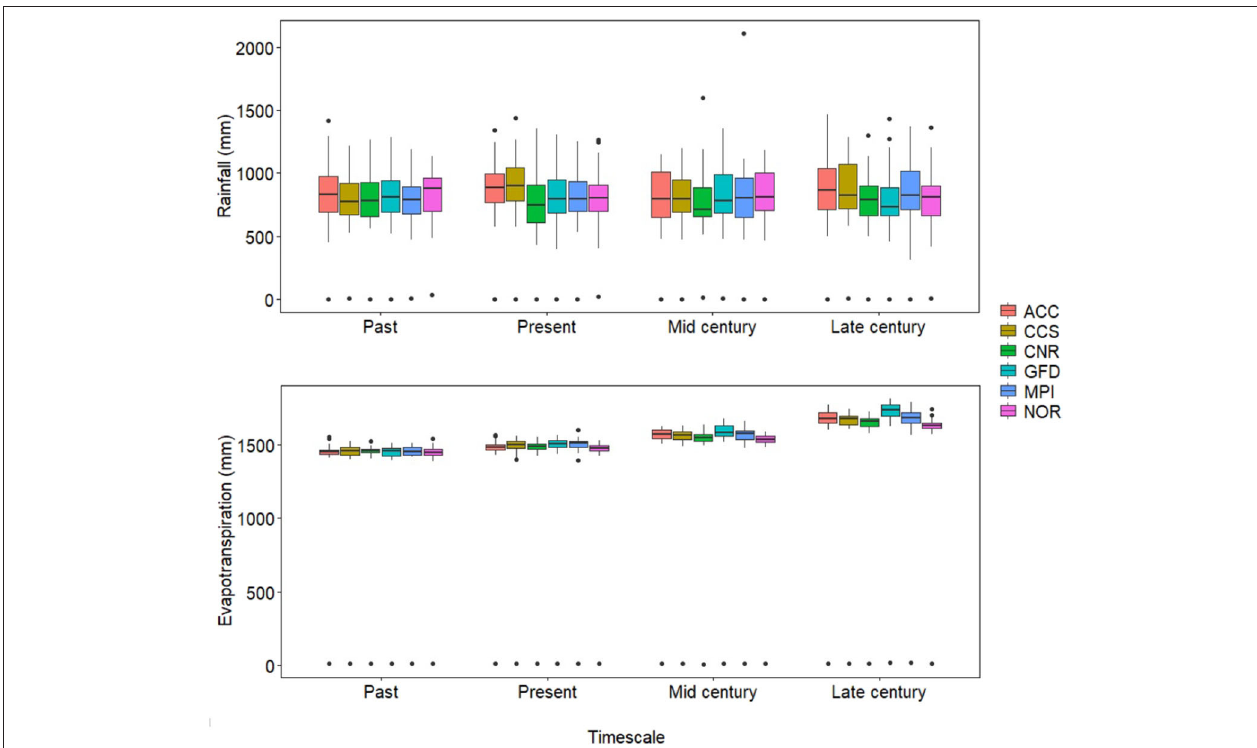
FIGURE 3 | Rainfall data representative of four different timescales (past, present, mid-, and late-century) as simulated by the six GCMs (ACC, CSS, CNR, GFD, NOR, and MPI). The average yearly rainfall calculated from observed rainfall data received between 2004 and 2019 was used as the mean annual rainfall.